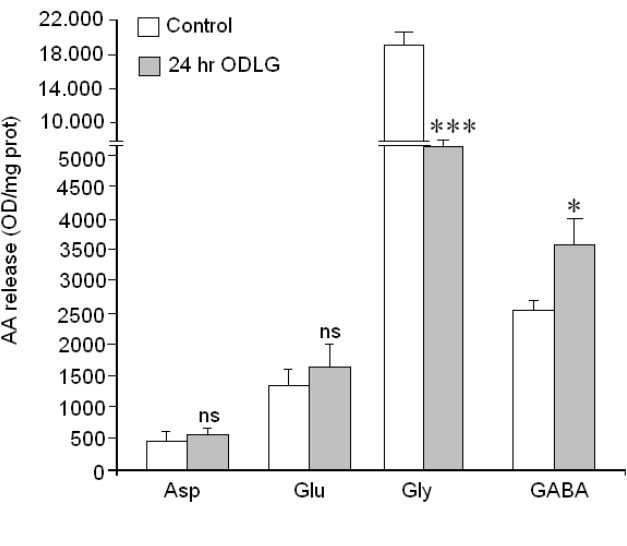
Figure 9. Effect of ODLG on amino acid neurotransmitter release evoked by high potassium levels (60 mM). Results are means ± SEM of two experiments with cells from different cultures, each one performed in triplicate with different batches of cells (6 measurements/condition). The statistical significance was assessed by comparisons between controls and cells subjected to ODLG for 24 h. ns = not significant ( vs .